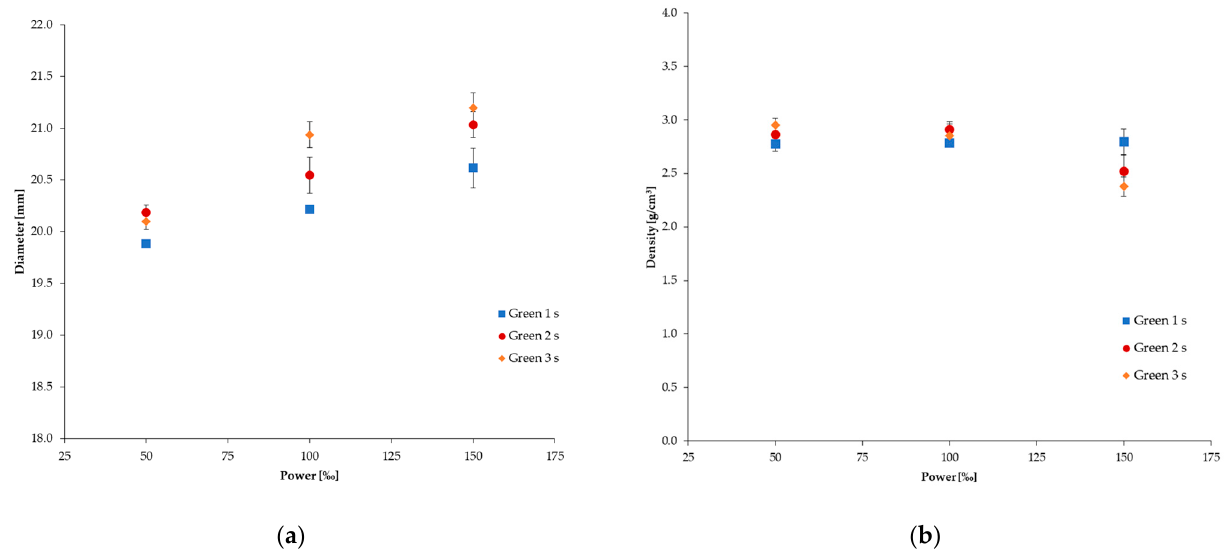
Figure 9. Diameter dimension ( a ) and measured density ( b ) of the DLPed discs with 25 µ m layer thickness.